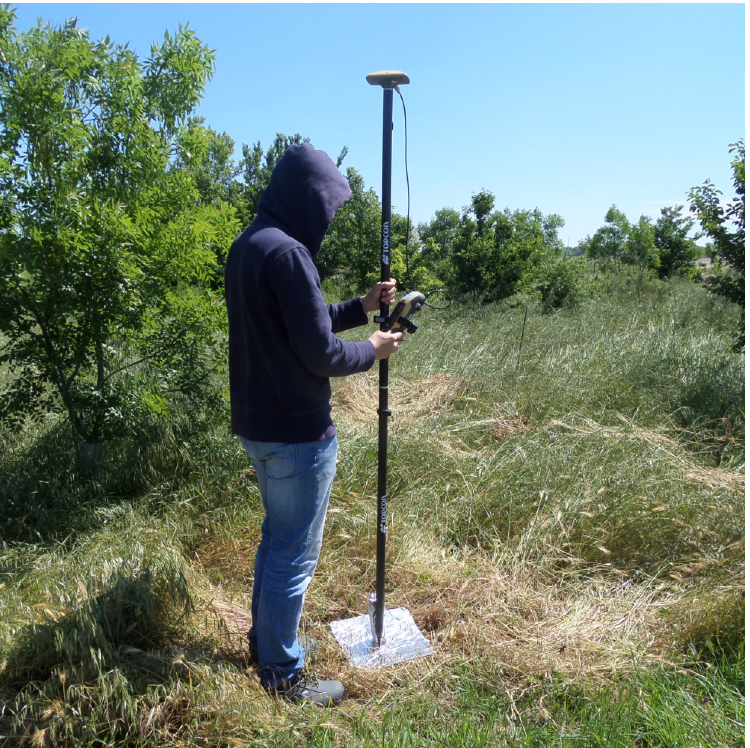
Figure 4. GNSS survey for a 0.3 × 0.3 m GCP, in an area beside the cultivated